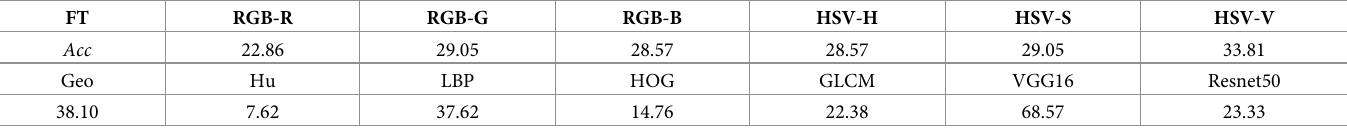
Table 11. Classification accuracy of multi-object features by RBFSVM using EMDS-5. F Feature type (FT), Accuracy (Acc), Geometric features (Geo), Hu moments (Hu). (In [%].). FT RGB-R Acc